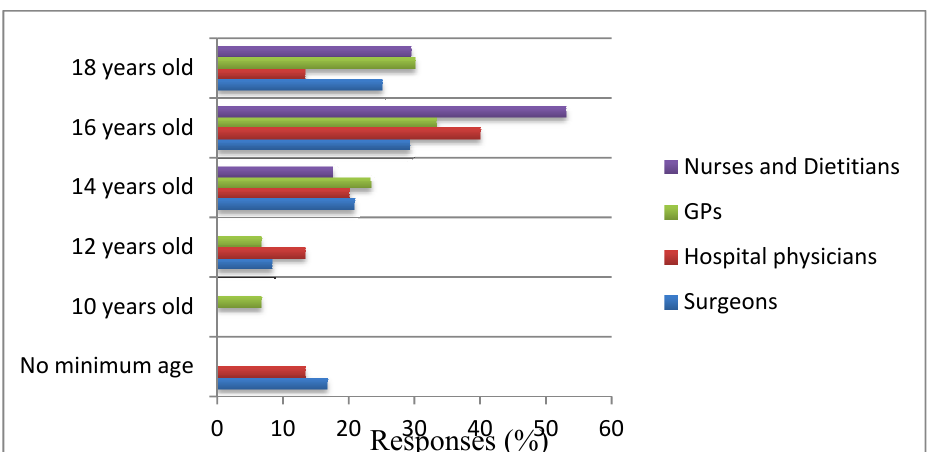
Figure 2. Minimum age for bariatric surgery.